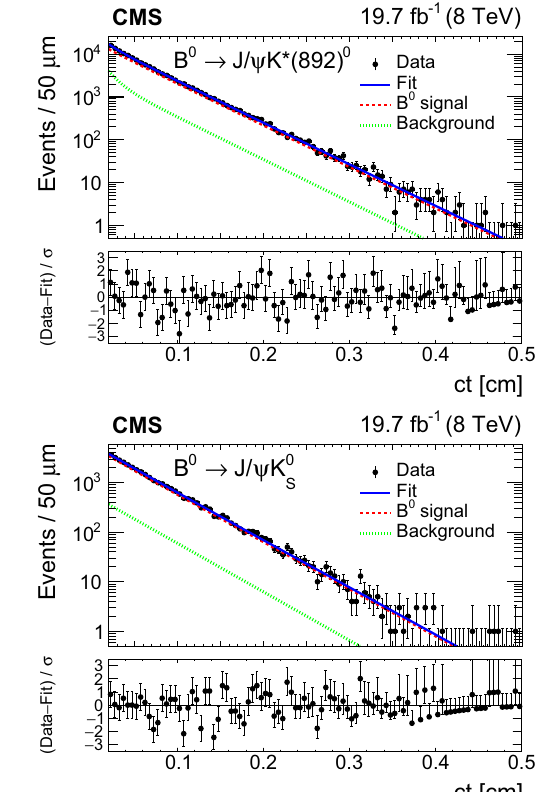
between the fitted functions and the data. The